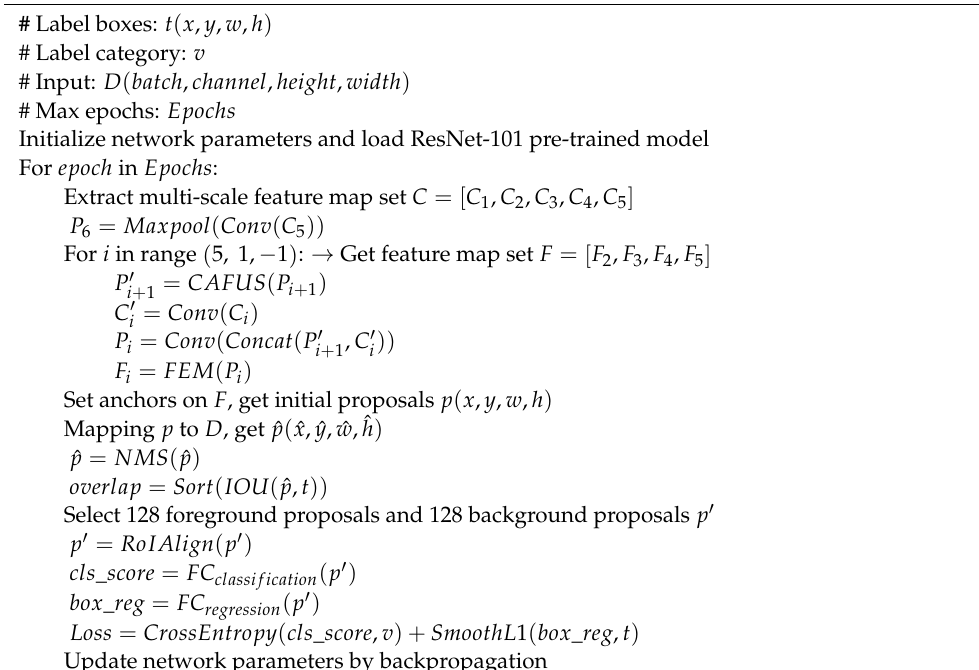
Algorithm 1 Training process pseudo-code of multi-scale feature